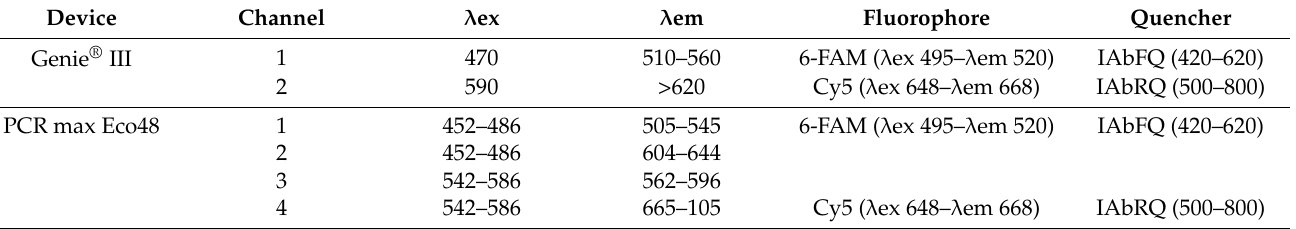
Table 2. Excitation and emission channels in Genie III portable instrument and PCRmax Eco 48 Real Time qPCR System used for real-time amplifications and corresponding fluorophores and quenchers used in DARQ-LAMP